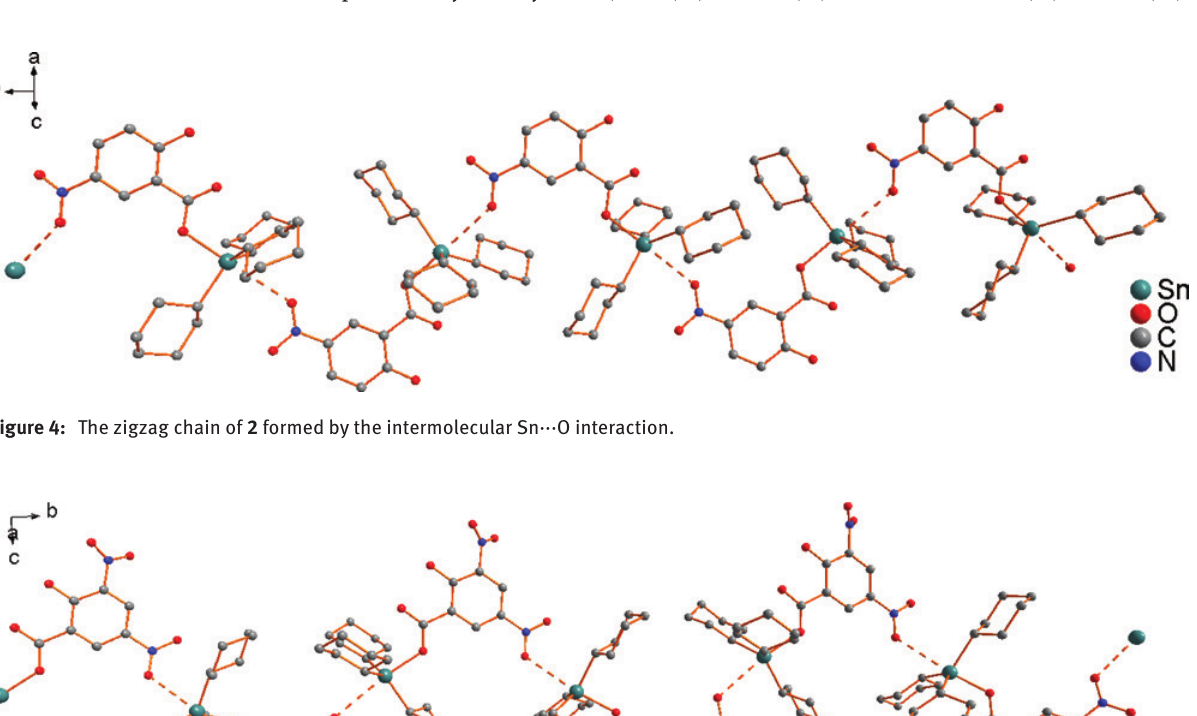
rationalized partly by the weak Sn(1)···O(2)